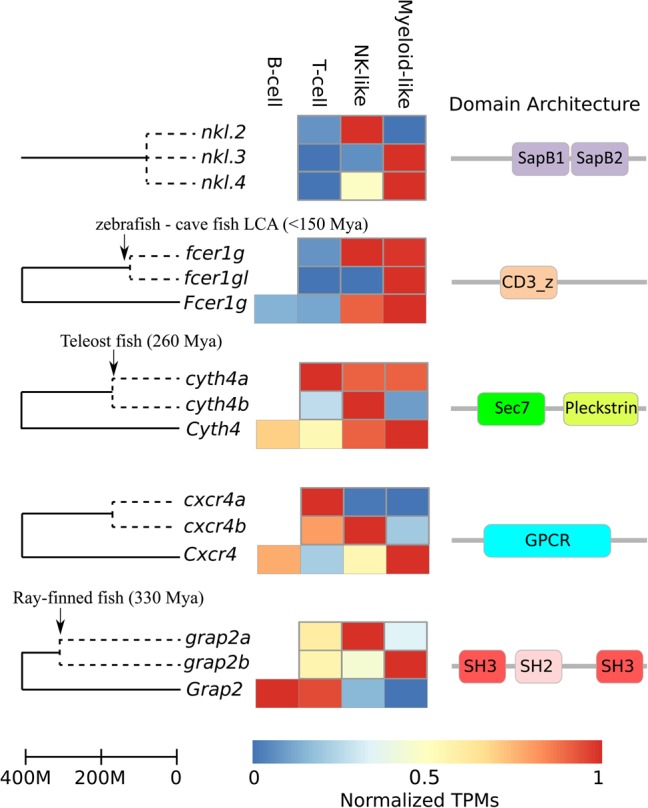
Examples of ray-finned fish–specific duplicated genes with diverged expression patterns. For genes with known mammalian orthologs, the expression in mouse is shown below. Estimated times of gene duplication are indicated with arrows. Domain architectures were retrieved from PFAM. (CD3_z) T-cell surface glycoprotein CD3 zeta chain; (GPCR) G-protein coupled receptor; (SH2/3) Src-homology 2/3.